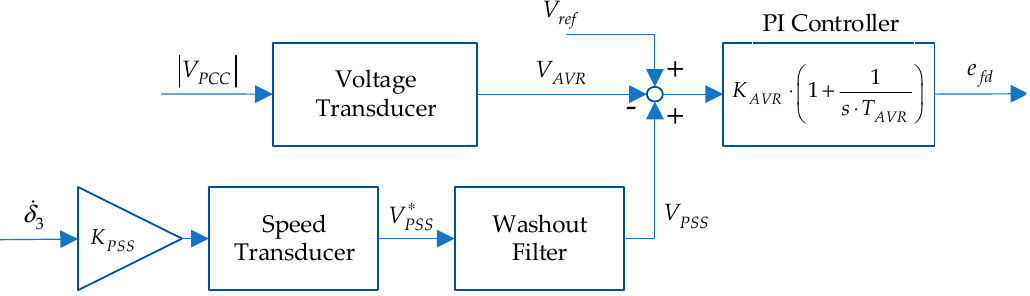
Figure 3. Automatic Voltage Regulator (AVR) and Power System Stabilizer (PSS) controllers.